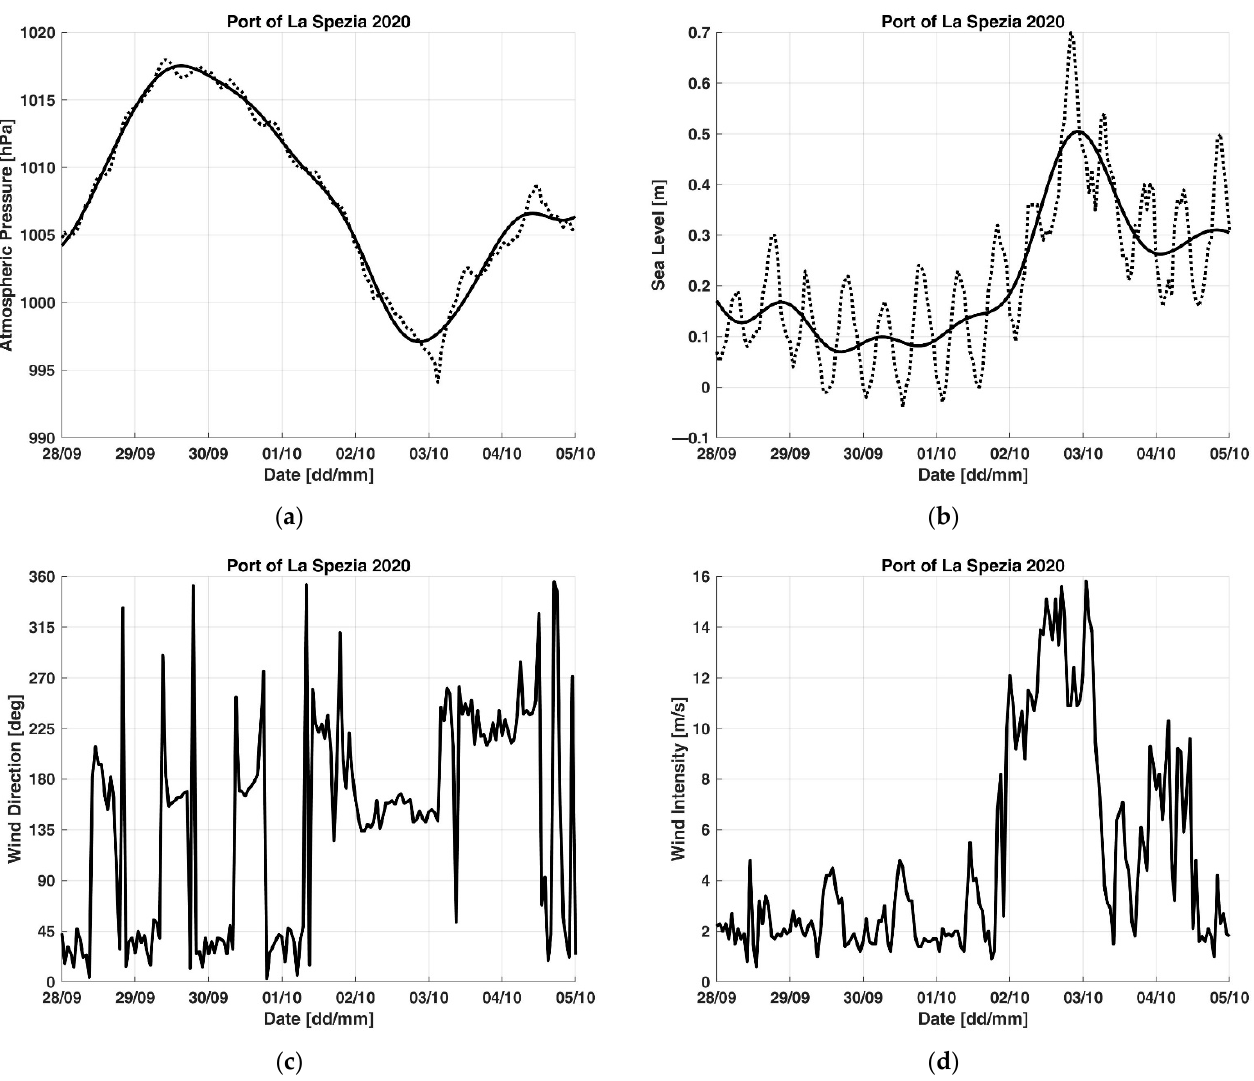
Figure 6. Measurements carried out between 28 September and 5 October 2020 inside the port of La Spezia: ( a ) atmospheric pressure; ( b ) sea level; ( c ) wind direction, clockwise from the North; ( d ) wind intensity; for ( a , b ) solid lines represent low-frequency components survived the Low-Pass filtering; dashed lines represent high-frequency components removed by the Low-Pass